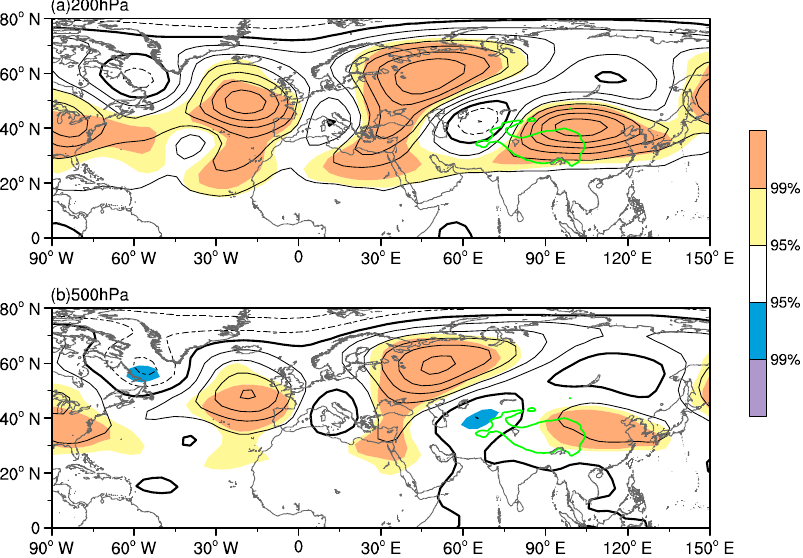
Figure 2. ( a ) Summer 200-hPa geopotential height anomalies (units: gpm) obtained by regression on the summer eastern TP SAT index for the period 1981–2019. ( b ) As in ( a ) but for 500-hPa. The green contours indicate areas >2500 m altitude, showing the TP (the same below). Contours are drawn every 4 gpm. The bold black line is zero. The solid and dash lines denote positive and negative values, respectively. Shadings denote geopotential height anomalies significant at the 95% and 99% confidence levels as shown by the color bars.